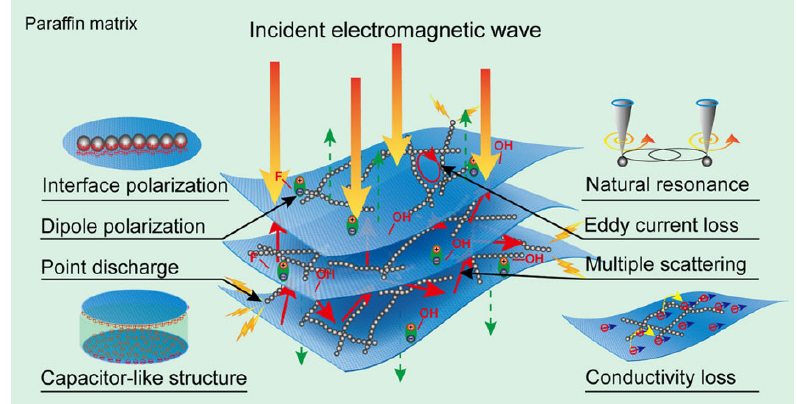
Fig. 28 EM wave loss mechanism of the MXene/Ni hybrid. Reproduced with permission from Ref. [250], © American Chemical Society